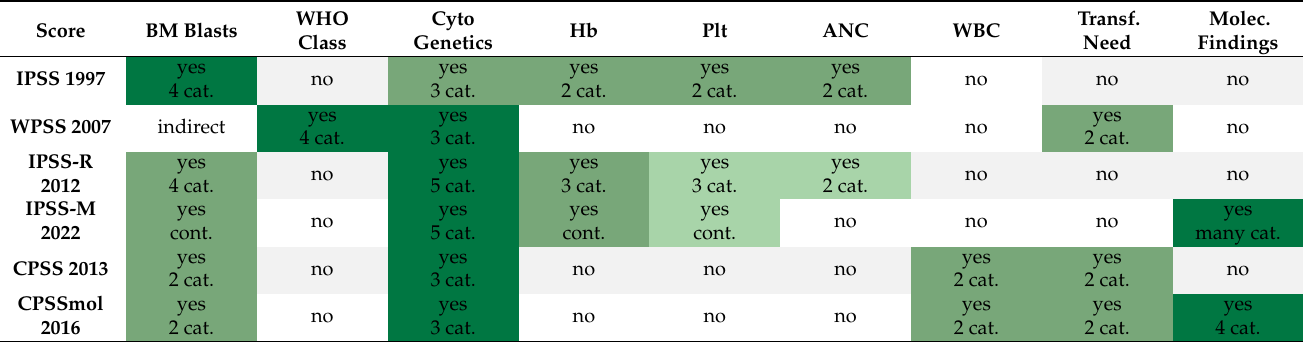
Table 3. Major prognostic scoring systems for patients with MDS or CMML (dark green to light green: most important to least important key factors in each soring